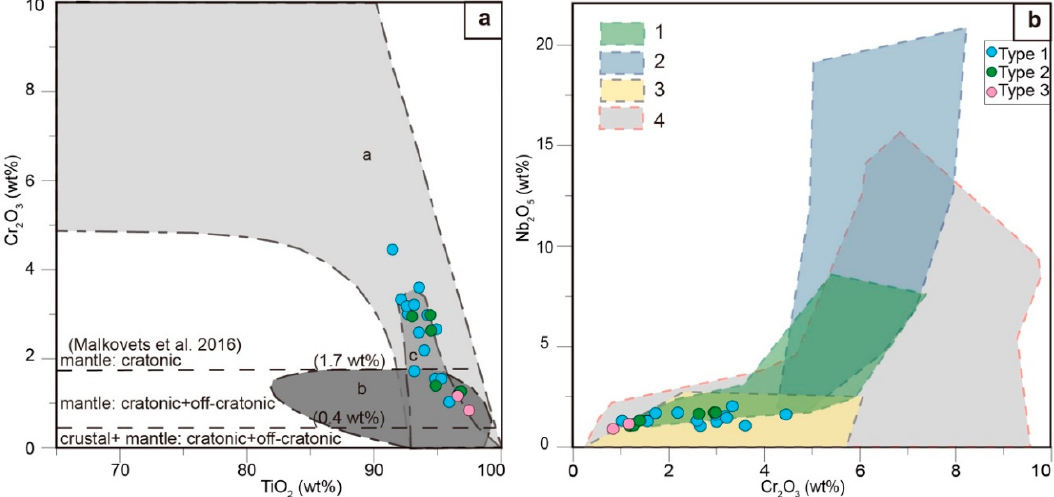
Figure 6. Chemical composition of the three di ff erent rutile types described in this work for the studied Menominee samples. ( a ) TiO 2 –Cr 2 O 3 plot (composition fields are according to [24]). Domain labeled “a” corresponds to rutile from cratonic deep-seated magmatic rocks, domain “b” to rutile from o ff -craton alkali basalts, and domain “c” to groundmass rutile from kimberlites. ( b ) Cr 2 O 3 –Nb 2 O 5 plot. Domain labeled 1 corresponds to rutile from the xenogenic material of kimberlites of South Africa [25]; domain 2 to rutile in metasomatic nodules from the kimberlites of the Orapa pipe, Botswana [25]; domain 3 to rutile inclusions in pyrope from Garnet Ridge [26]; and domain 4 to rutile inclusions in pyrope from the Internatsionalnaya pipe [27].